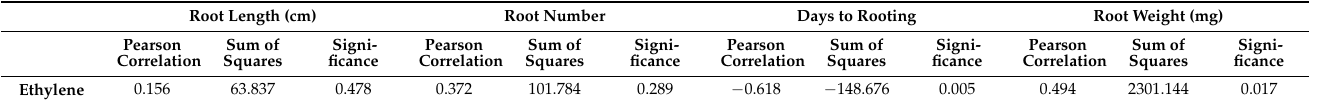
Table 3. Pearson correlations between root length (cm), root number, days to rooting, root weight (mg) and ethylene production as affected by exposure to UV-C irradiation over a period of 6 weeks. Correlation analysis was performed in SPSS v.